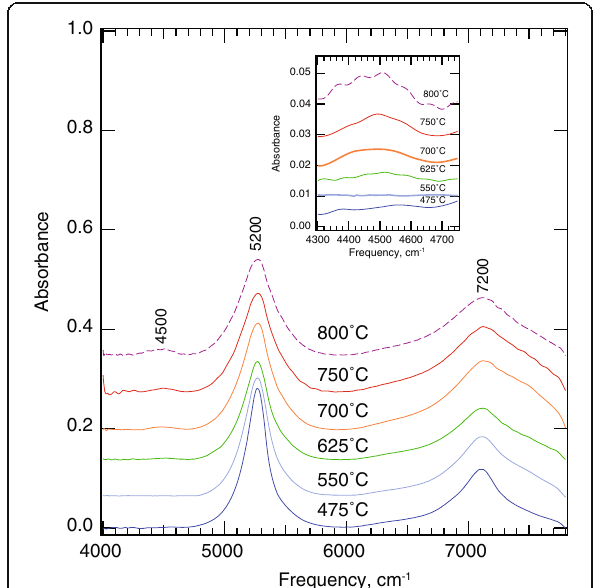
Fig. 2 FTIR spectra of fluid at temperatures indicated. Corresponding pressures can be found in Table 1. The dashed line is the spectrum from a single-phase fluid. Insert shows expanded view of frequency region centered at 4500 cm − 1 . Note that all spectra are offset for clarity. The 0-intensity line passes through the background at 600 cm − 1 . In the insert, the 0 line is approximately that near 4300 cm − 1